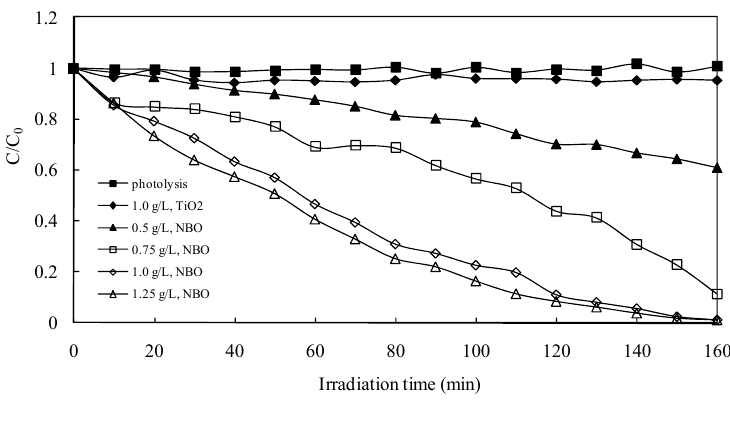
Figure 4. Effect of NaBiO dosage on the photocatalytic degradation rate of acridine 3 orange (AO). Experimental conditions: AO concentration 0.1 g L − 1 ; pH 8.